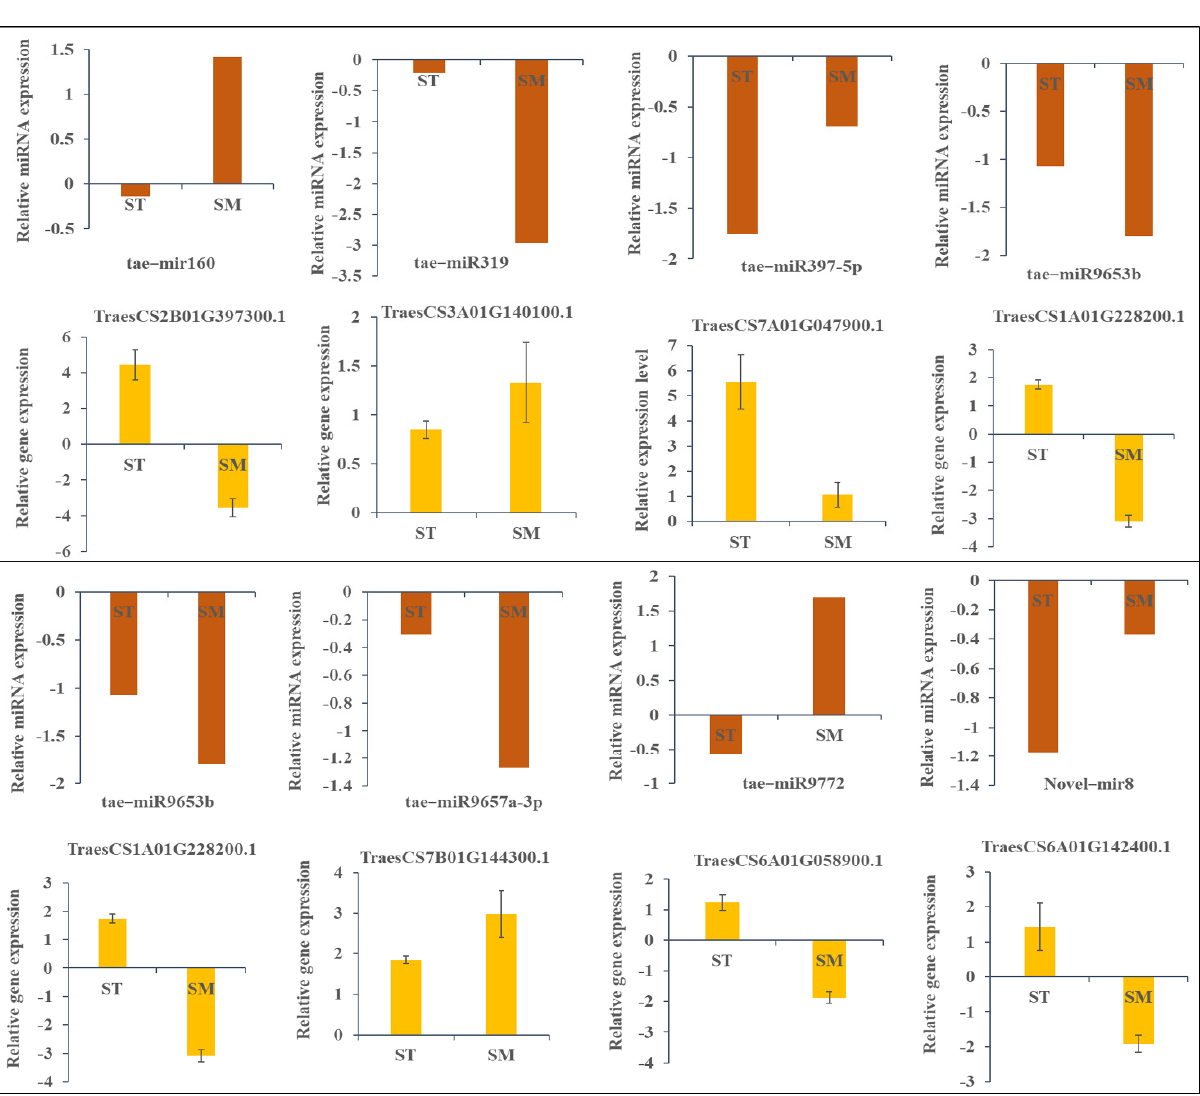
Figure 5. Validation of eight differentially expressed miRNAs and target genes in roots of Suntop (ST) and Sunmate (SM) from HTS analyses. Relative miRNA expression is the fold change in normalized reads from the sequencing of sRNAs between the NaCl treatment and the control. Fold change was calculated as log 2 (NaCl reads/control reads). Data related to miRNA expression are the means of two biological replicates, while the data from the gene expression studies are the means of three biological replicates and two technical replicates.